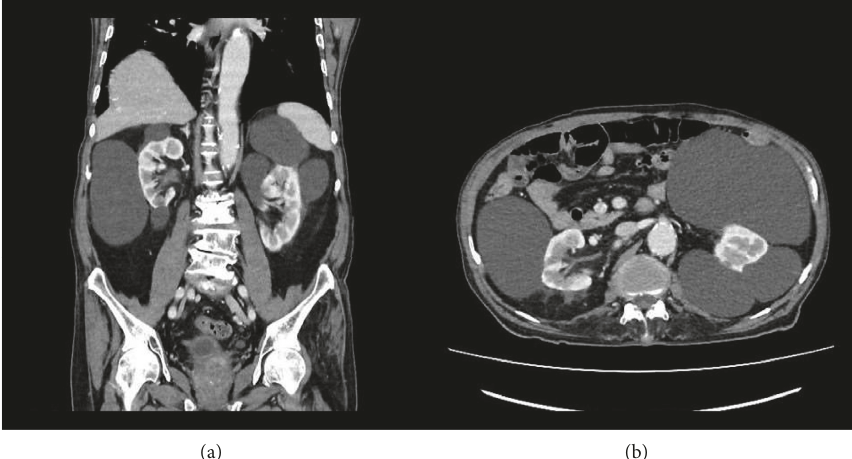
Figure 2: Coronal (a) and axial (b) CT images of the abdomen revealed multiple, variable-sized, thin-walled cysts in both kidneys. The diameter of the cysts ranged from 3.5–13.0cm. Some renal cysts had higher attenuation with perinephric fat stranding, representing infected renal